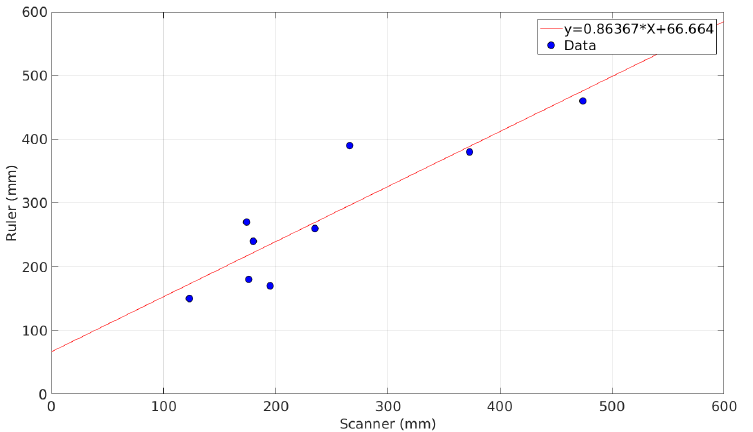
Figure 16. Comparison between the values measured with a rule and the values measured with the scanner using variable height from the